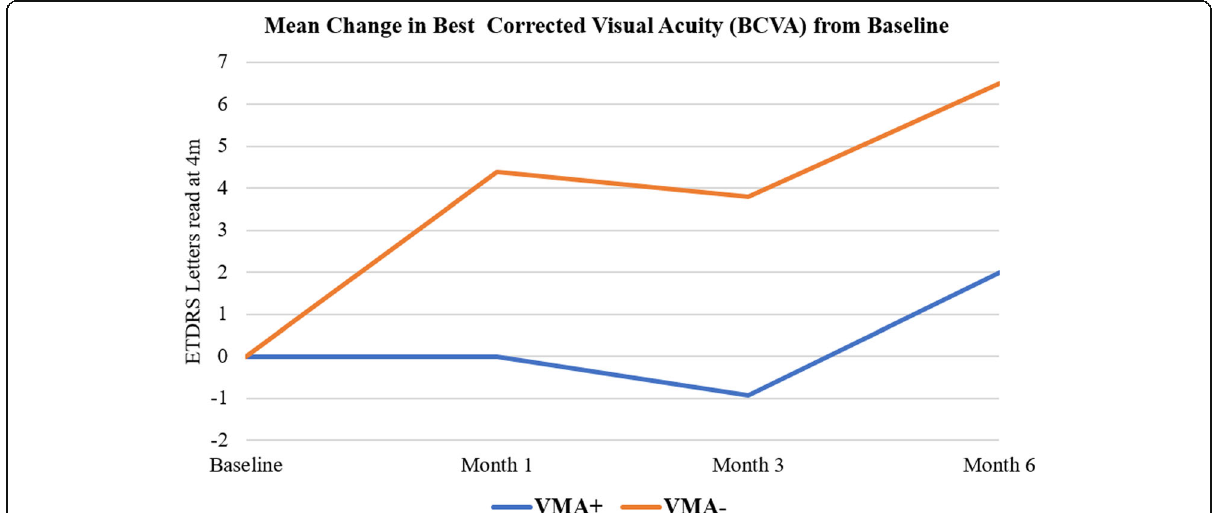
Fig. 1 Mean change in best-corrected visual acuity. The mean change in best-corrected visual acuity (BCVA) from baseline at different study intervals for the 2 study groups. ETDRS, Early Treatment Diabetic Retinopathy Study; VMA+, vitreomacular adhesion present; VMA − , vitreomacular adhesion absent